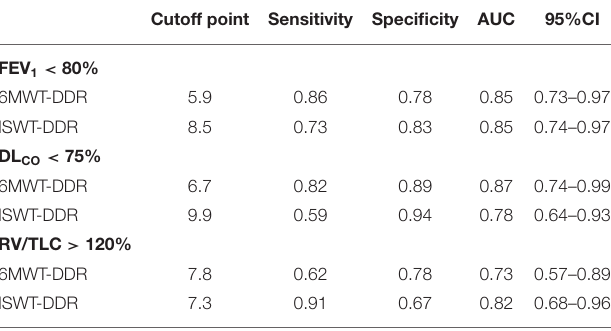
TABLE 2 | The optimum cutoff points and ROC curve parameters for prediction of lung function and DDR in patients with LAM. Cutoff point Sensitivity Specificity AUC